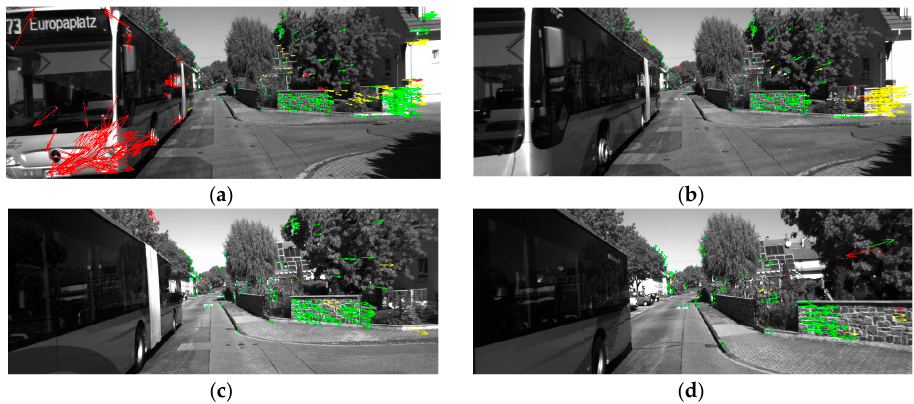
Figure 4. The feature points tracking results in scenario 1. ( a ) Frame 2624; ( b ) Frame 2625; ( c ) Frame 2628; ( d ) Frame 2632. (The green arrows represent the points selected for computation, the red ones are the points rejected by the SPC, and the yellow ones are the points rejected by the RANSAC algorithm.) Table 1. Number of the green points and proportion of the inliers.